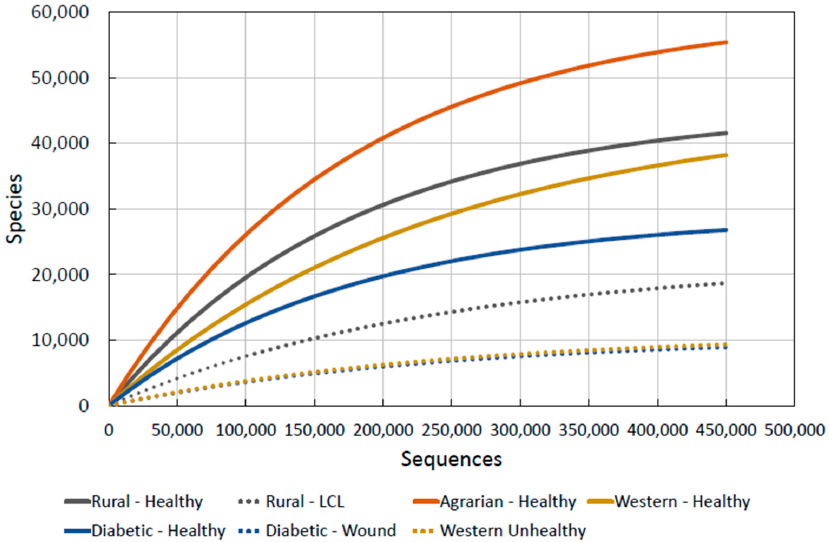
Figure 6. Combined skin microbiota diversity.